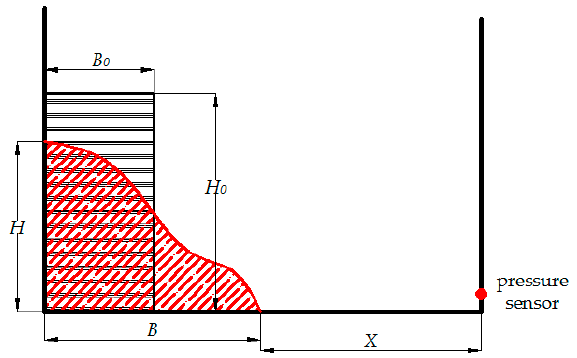
Figure 9. The profile of the water in the dam break case.